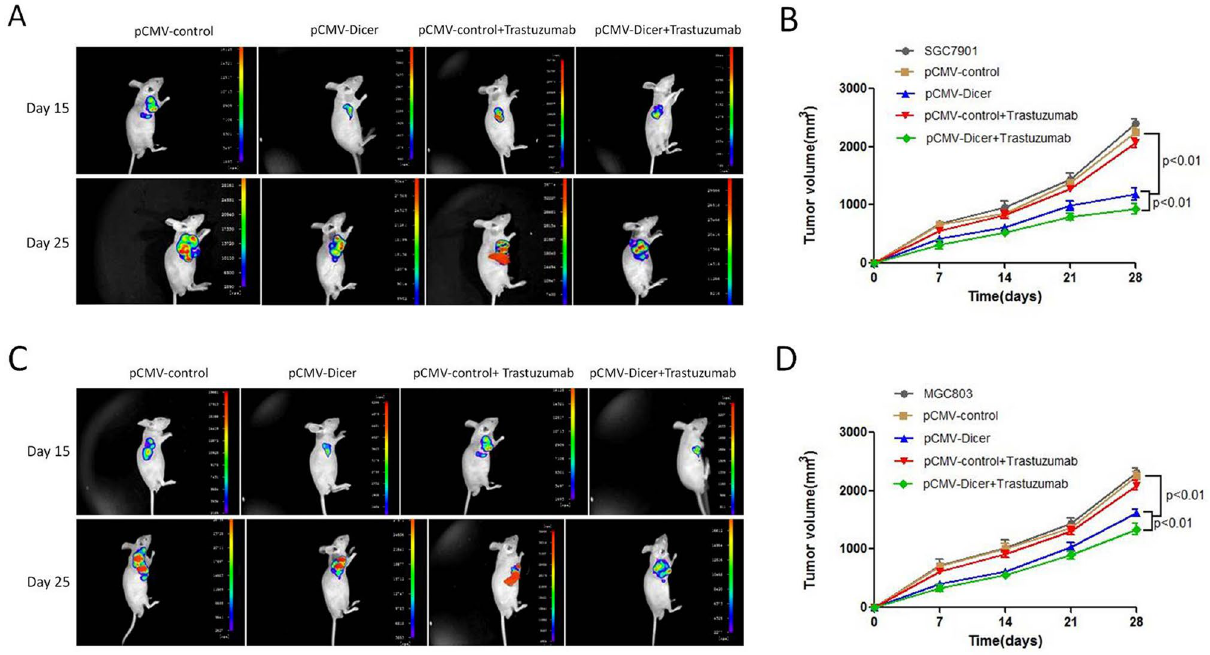
Figure 3. Effects of Dicer overexpression and treatment with Trastuzumab on GC cell growth in vivo. ( A ) Fluorescence image of mice bearing SGC7901 cells xenografts; ( B ) Tumor growth was monitored by measuring tumor volume for SGC7901 xenografts (n = 6 for each group); ( C ) Fluorescence image of mice bearing MGC803 cells xenografts; ( D ) Tumor growth was monitored by measuring tumor volume for MGC803 xenografts (n = 6 for each